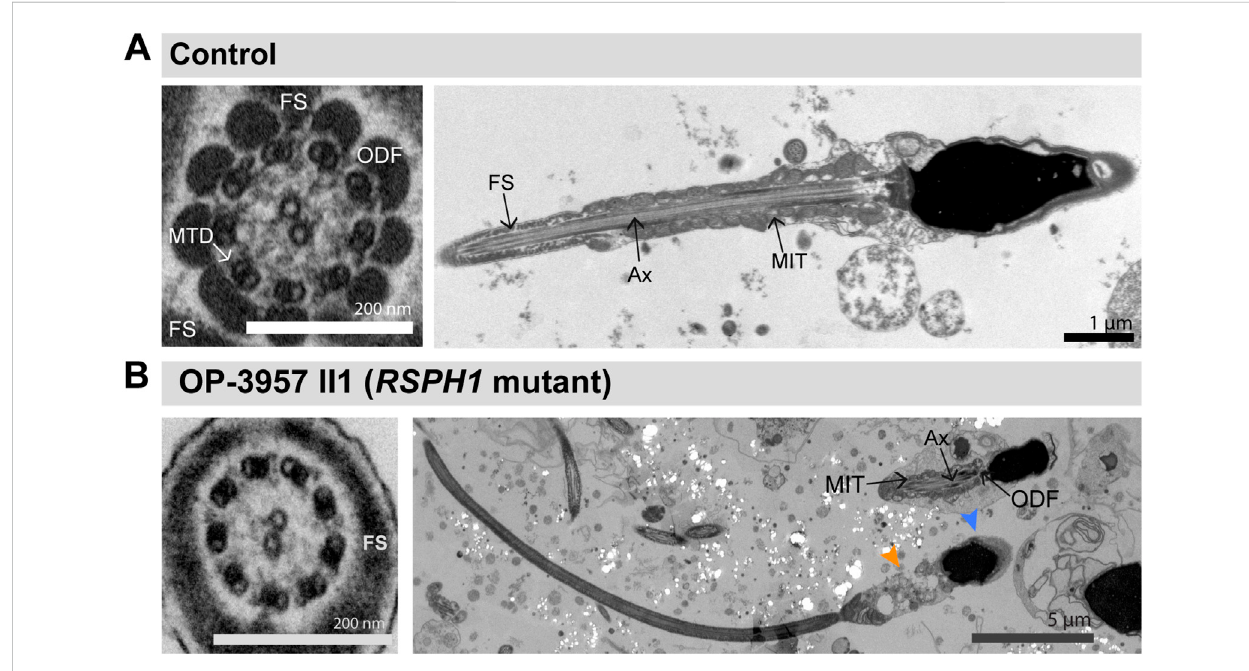
TEM analyses of RSPH1 -mutant sperm cells displayed morphological abnormalities of the midpiece and head region, but preservation of the 9 + 2 axonemal organization. (A) TEM micrographs of sperm samples from a healthy control donor, showing a fl agellar cross section with a regular 9 + 2 axoneme of microtubule doublets (MTD), (left image), and a longitudinal section, with regularly arranged mitochondria (MIT) and fi brous sheath (FS), respectively in the fl agellar mid piece and principal piece (right image). (B) TEM micrographs of sperm samples from the RSPH1 -mutant individual OP-3957 II1 show morphological abnormalities with dysplasia of the fl agellar midpiece and abnormal head shapes (respectively indicated by orange and blue arrowheads), or sperm with only a cytoplasmic bag containing unassembled axonemal (Ax) and peri-axonemal components, such as outer dense fi bers (ODF) and MIT (right image). Some sperm fl agellar cross sections also display a normal ultrastructure with a regularly disposed 9 + 2 axoneme (left